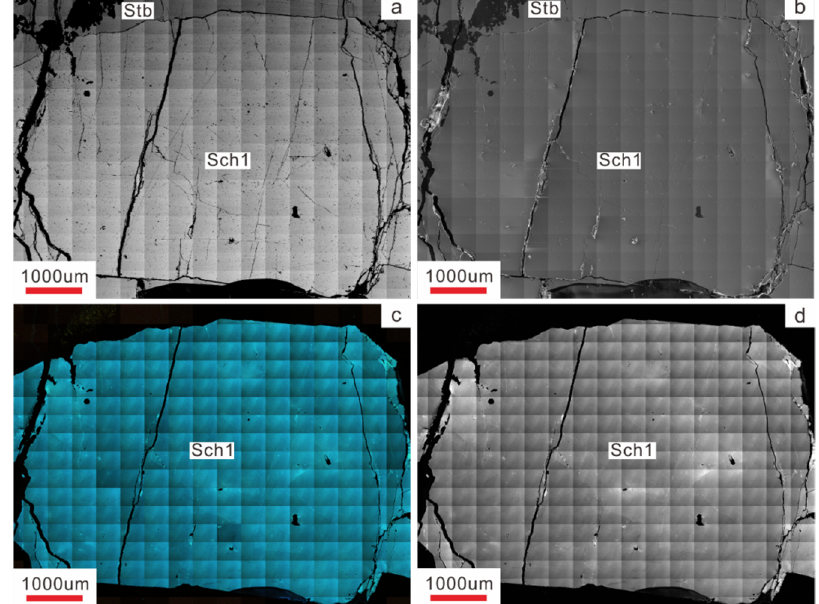
Figure 8. The ( a ) Backscattered electron (BSE) image; ( b ) Scanning Electron Microscopy (SEM) image; ( c ) Colorful Cathodoluminescence (CL) image; and ( d ) Grey Cathodoluminescence (CL) image of the Sch1 from the Longshan Sb-Au deposit indicate that its chemical composition is homogeneous.